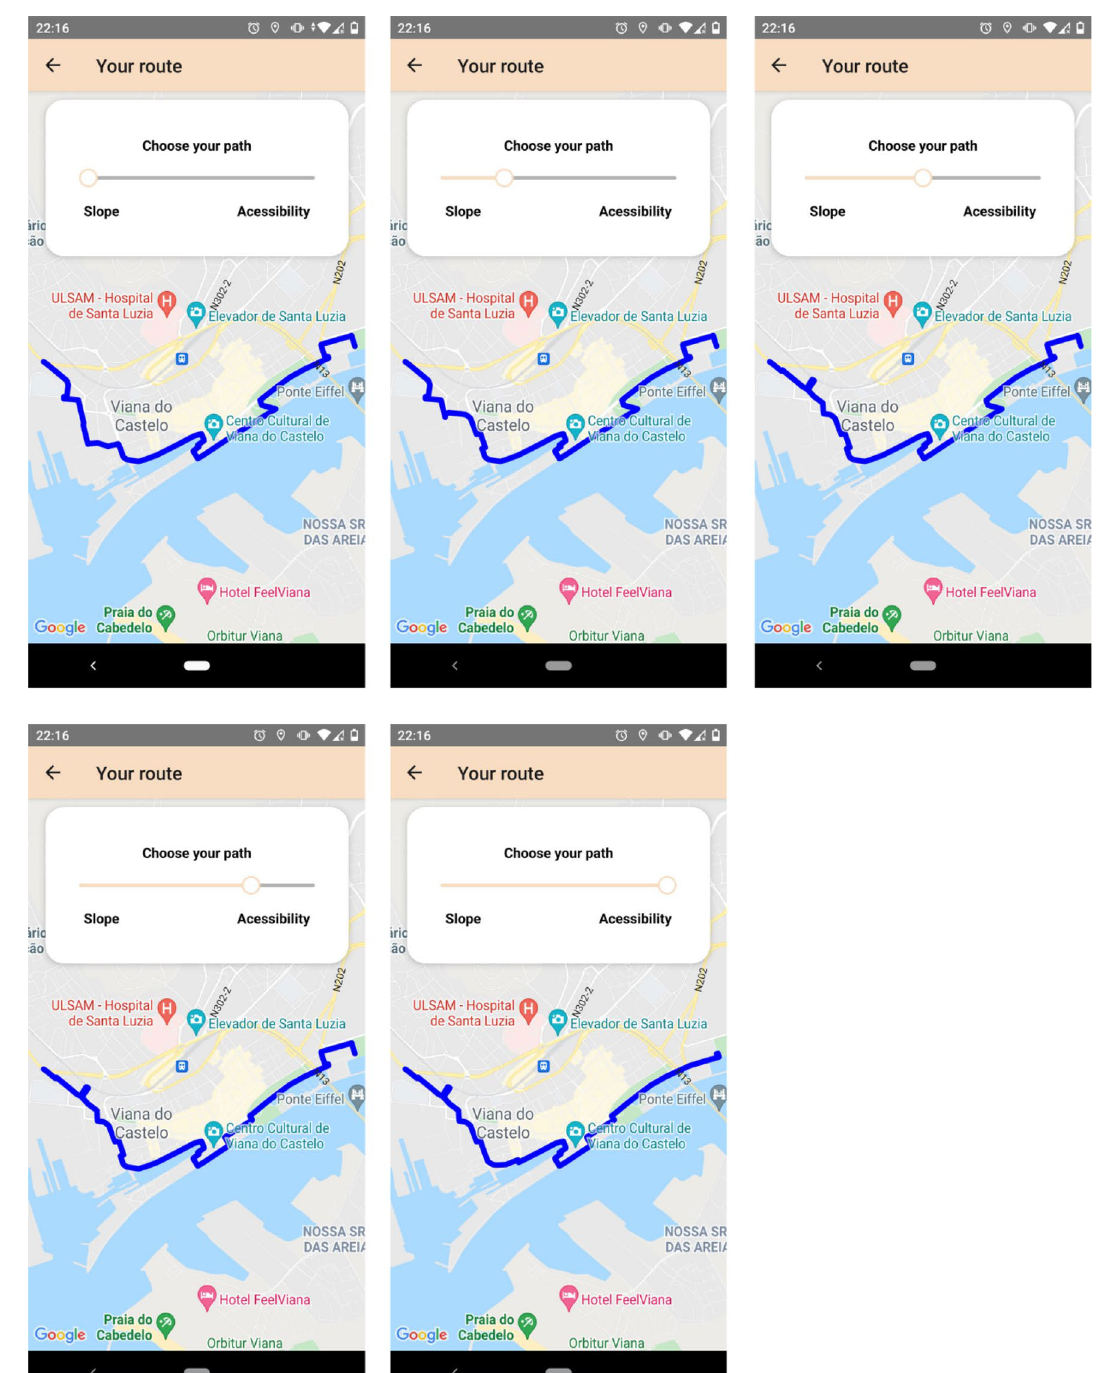
Fig. 6 Optimal paths for path L